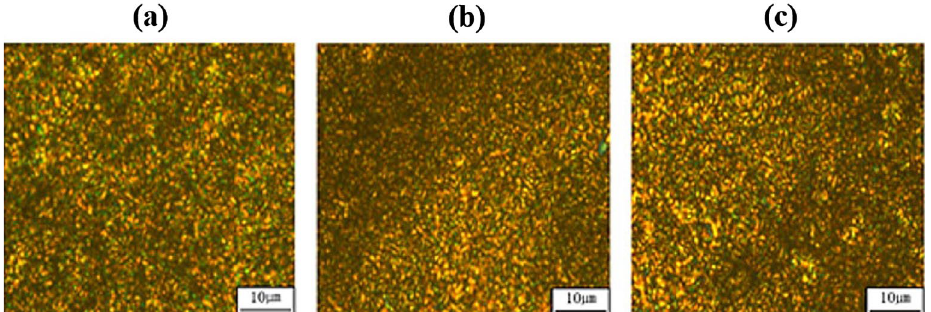
Figure 2. POMs of ( a ) P-3 at 280 °C, ( b ) P-4 at 295 °C, and ( c ) P-5 at 315 °C (magnification 200